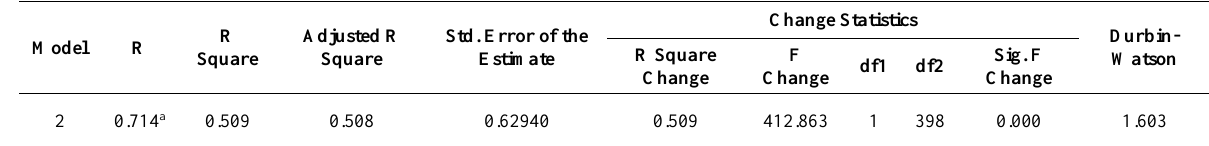
Table 8. Model Summary